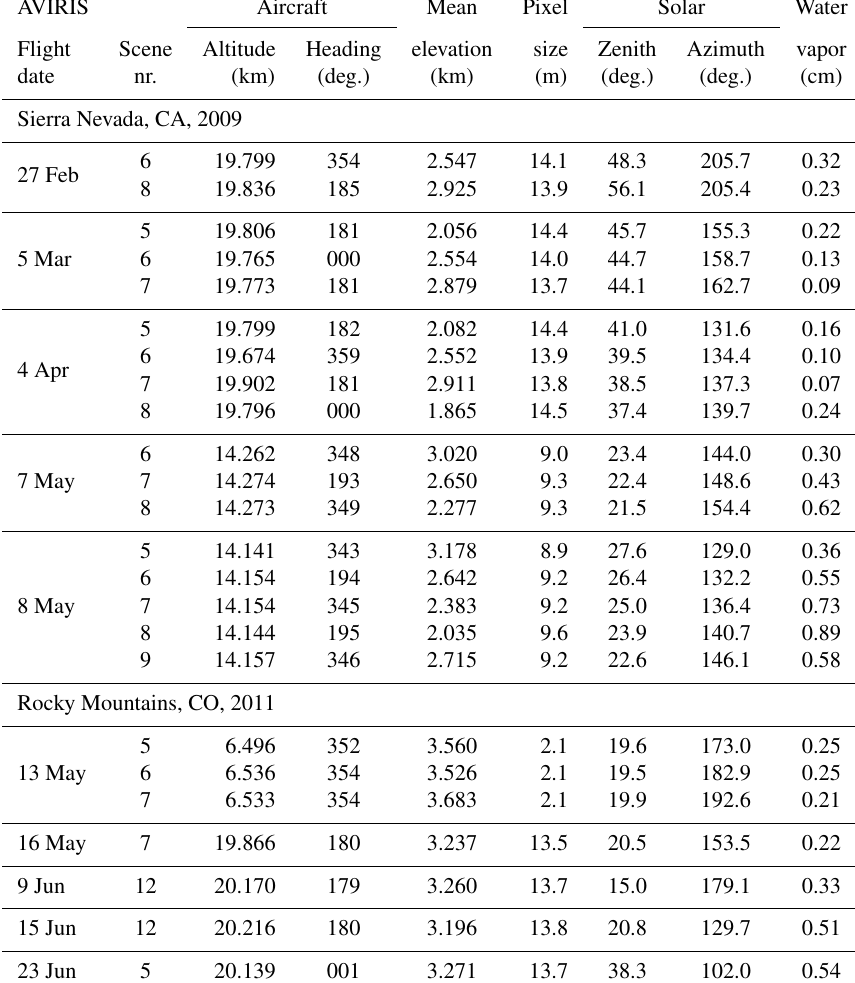
Table 2. Summary of the individual AVIRIS scenes used in this paper. The scene number corresponds to the AVIRIS “run ID”. The aircraft altitude, heading and the terrain elevation are averages per scene. The solar geometry is valid at the center of a scene. Water vapor is retrieved using ATCOR-4 (see Sect.